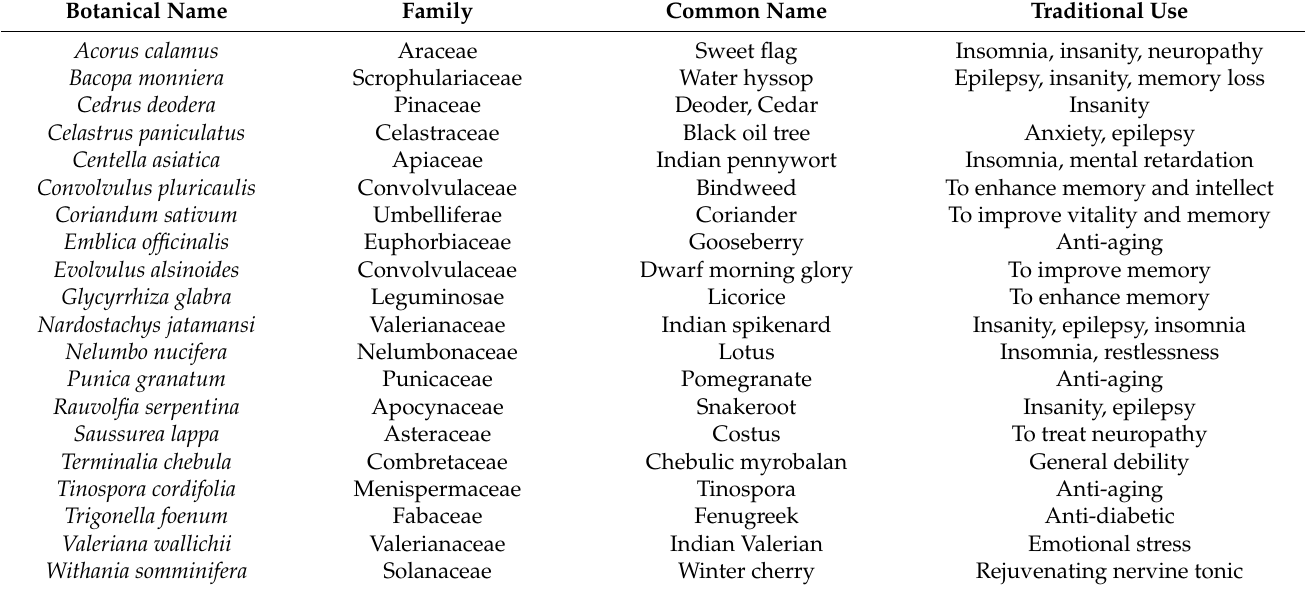
Table 2. List of Medicinal Plants and Their Traditional Uses Related to CNS